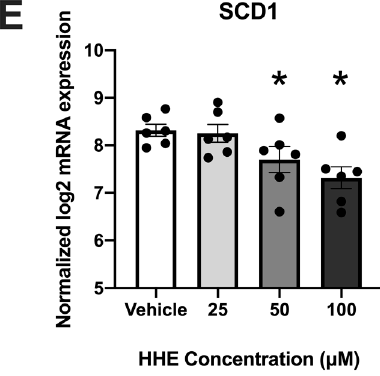
Figure 1. HHE exposure decreases fatty acid metabolism-associated genes in a concentration- dependent manner in human placental explants (( A ), MFSD2a; ( B ), LDLR; ( C ), SREBP1; ( D ), SREBP2; ( E ), SCD1); n = 6. Data (means ± standard error of the mean) are expressed as normalized log2 mRNA expression. * p < 0.05, ** p < 0.01; data compared by non-parametric repeated measures, one-way ANOVA and Dunn’s multiple comparison test.